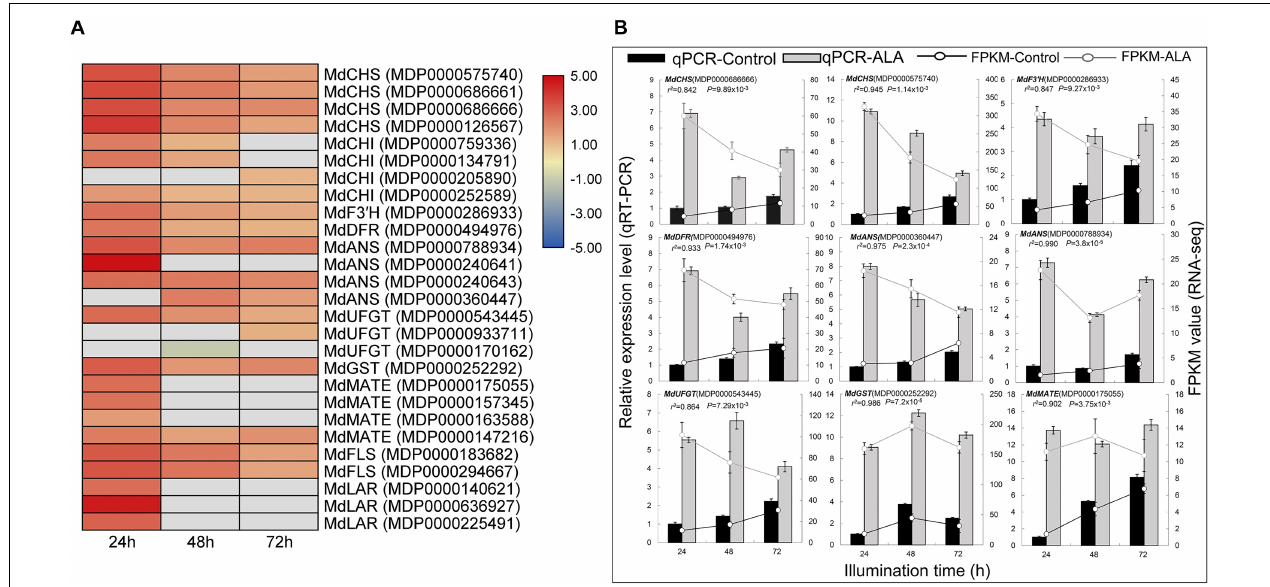
FIGURE 4 | Expression pattern of genes involved in flavonoid biosynthesis and transport. (A) Heat map representation of transcriptional profiles of DEGs in the flavonoid biosynthesis pathway. The depth of color represents the changes of the value of log 2 [fold change (FC)], and red represents up-regulation and blue represents down-regulation. The gray represents the relative differential expression level of those genes that did not reach screening threshold of DEGs in one or two time points after ALA treatment. (B) Verification of the expression of DEGs in the flavonoid biosynthesis pathway by